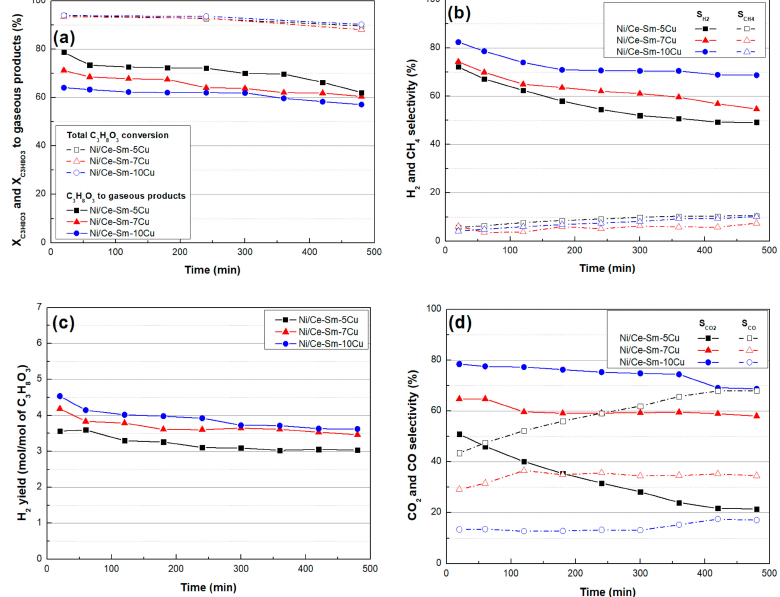
Figure 13. Time on stream experiments for all catalysts: ( a ) Total glycerol conversion and glycerol conversion into gaseous products; ( b ) CH 4 selectivity; ( c ) H 2 yield; ( d ) CO 2 ; and CO selectivity [Results obtained for samples tested under experimental protocol